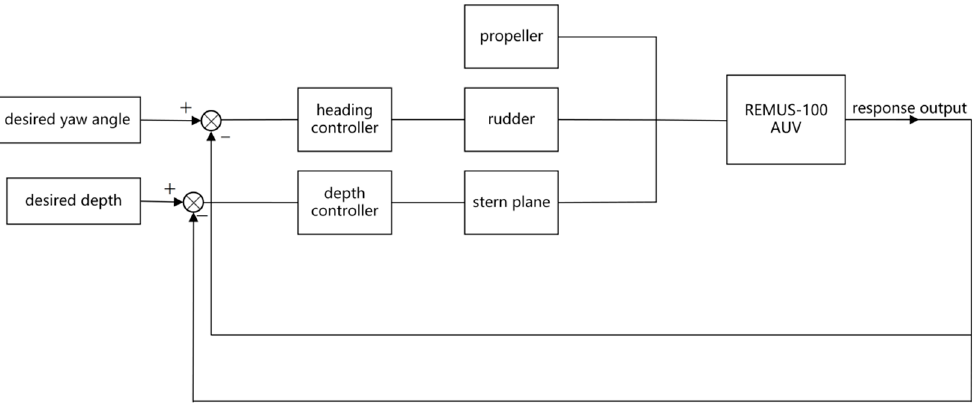
Figure 8. REMUS-100 AUV control system.